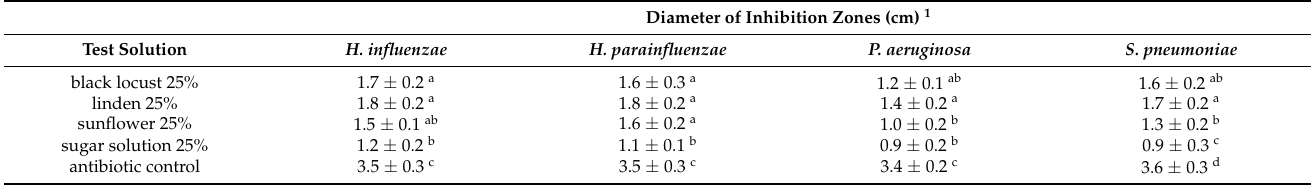
Table 2. Results of the agar well diffusion assay with 25% honey and sugar solutions, compared to antibiotics as positive control. Inhibition of bacterial growth was indicated by the appearance of a zone of inhibition around the